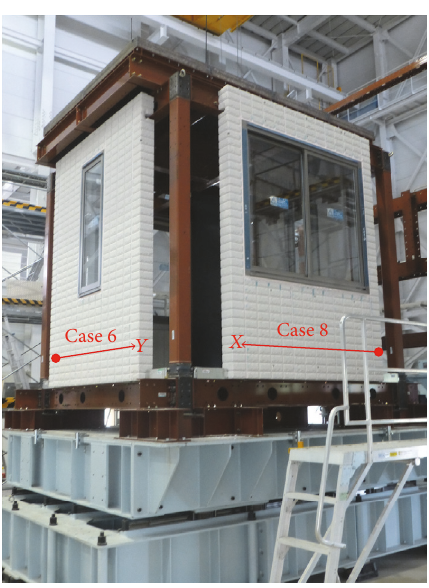
Figure 7: External view of Case 10